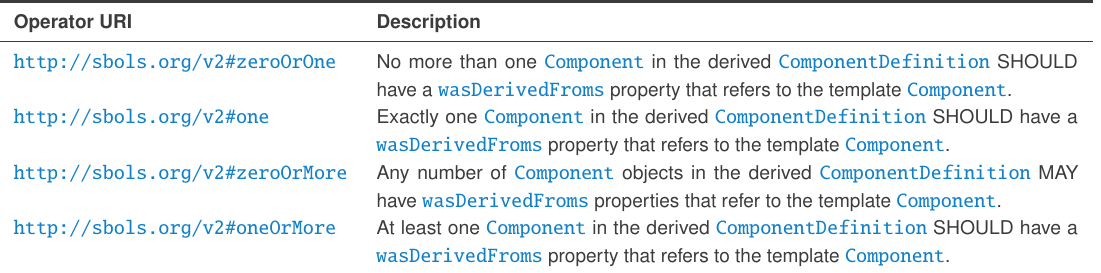
Table 16: REQUIRED URI s for the operator